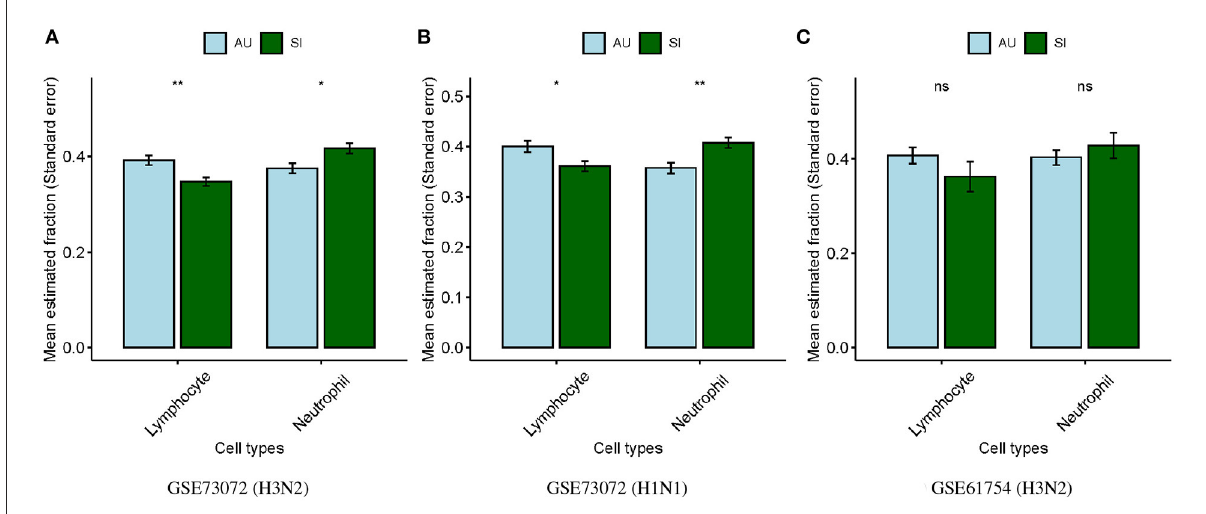
FIGURE3 Differences in estimated lymphocyte and neutrophil proportions at baseline between SI and AU groups in the discovery (A) and validation cohorts (B,C) .